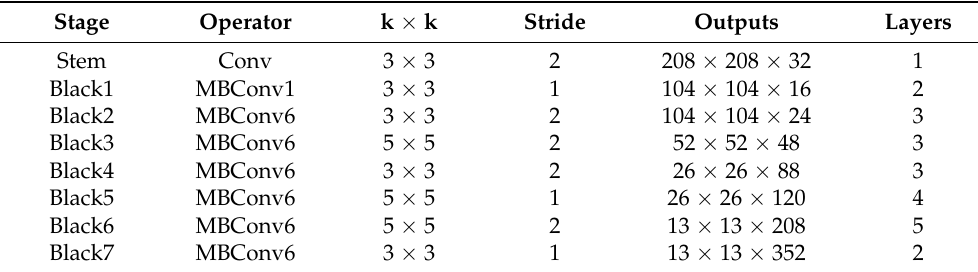
Table 1. EfficientNet-b2 feature extraction network structure.